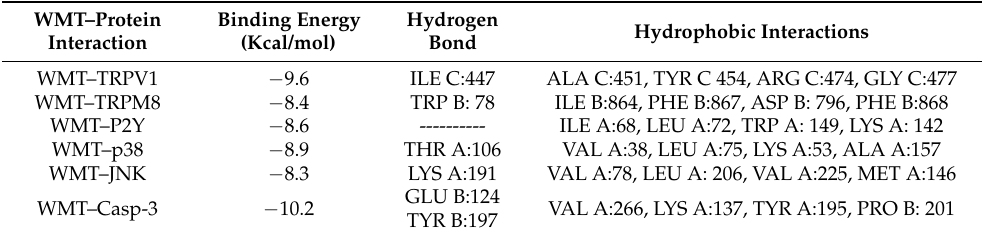
Table 3. The docking analysis of withametelin with TRPV1, TRPM8, P2Y, p38, JNK, and caspase-3. WMT–Protein